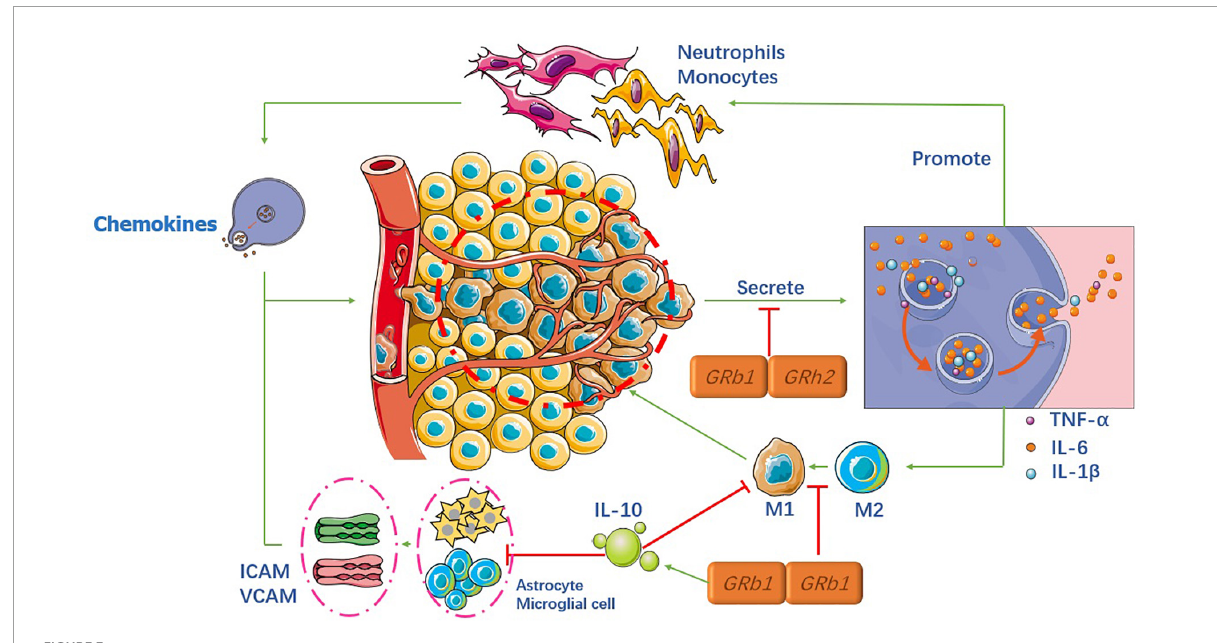
FIGURE3 Mechanism of the anti-apoptotic properties of